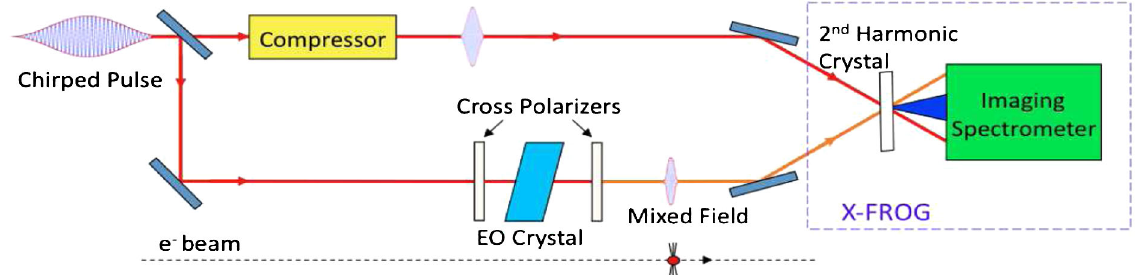
FIG. 2. BMX-FROG setup used to measure ultrashort charged particle bunches.